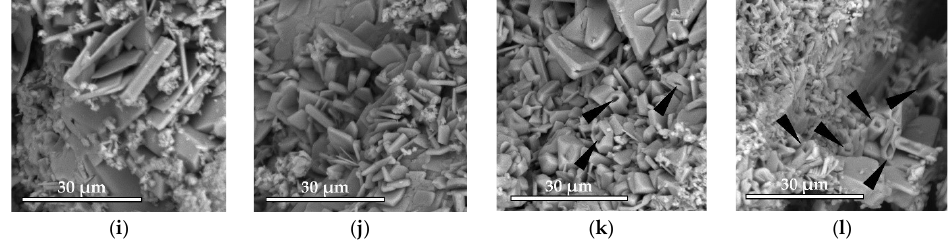
Figure 8. Micrographs of ceramics after physiological solution: N0_LP0.6 ( a – d ); N0_SPP_LP0.6 ( e , f ); N0_CA_LP0.6 ( g , h ); N0_LP0.7 ( i ); N20_LP0.7 ( j ); N40_LP0.7 ( k ); N60_LP0.7 ( l ). Magnification ×2500 for ( a ), ( c ), ( e ), ( g ). Magnification ×5000 for ( b ), ( d ), ( f ), ( h – l ). A quantitative analysis of the phase composition of incubated ceramics is shown in Figure 9. The ratio of the phases of monetite and brushite after the incubation of ceramics in saline solution did not change for the composition N0_LP0.6. The amount of brushite increased slightly in incubated formulations with the introduction of SP, and it increased by about 17% with the introduction of CA or SPP_CA together.